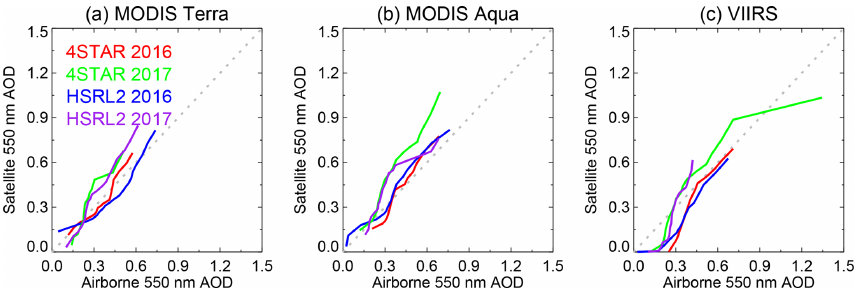
Figure 10. Quantile–quantile (QQ) plots comparing distributions of AODs from co-located satellite and airborne measurements, from 5th to 95th percentiles of the matched data. Panels show (left–right) data for MODIS Terra, MODIS Aqua, and VIIRS matchups. Colours are as in Fig. 8. The 1 : 1 line is dotted grey.